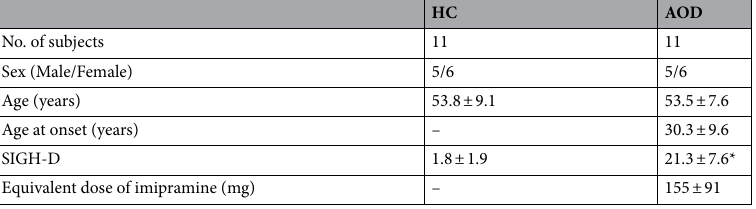
Table 4. Participants demographics and characteristics in Group 2 (independent test samples). Data are shown as the mean ± standard deviation. *p < 0.05 compared to HC. AOD, adult-onset depression; HC, healthy controls; SIGH-D, Structured Interview Guide of the Hamilton Depression Rating Scale